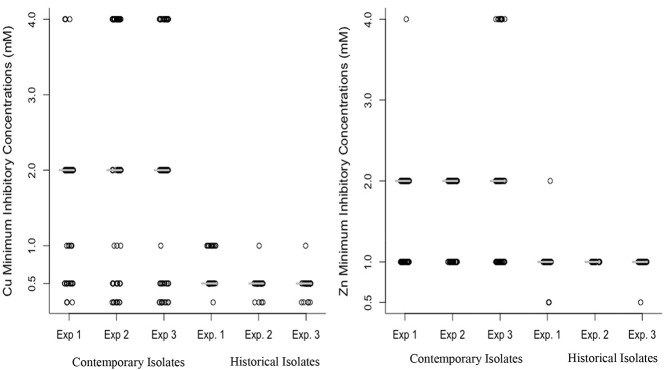
Distribution of minimum inhibitory concentration (mM) of copper (left) and zinc (right) for 63 contemporary (2012–2016) and 31 historical (1980's) isolates of Histophilus somni. The MIC value for the isolates tested was in triplicate in three replicate experiments (Experiments 1 and 2). The median value of copper and zinc in contemporary and historical isolates was consistent in all three experiments, indicating the reproducibility of the metal tolerance assay. A Mann-Whitney U test was used for comparing median MIC between historical and contemporary isolates and a significant difference was detected (P < 0.001).